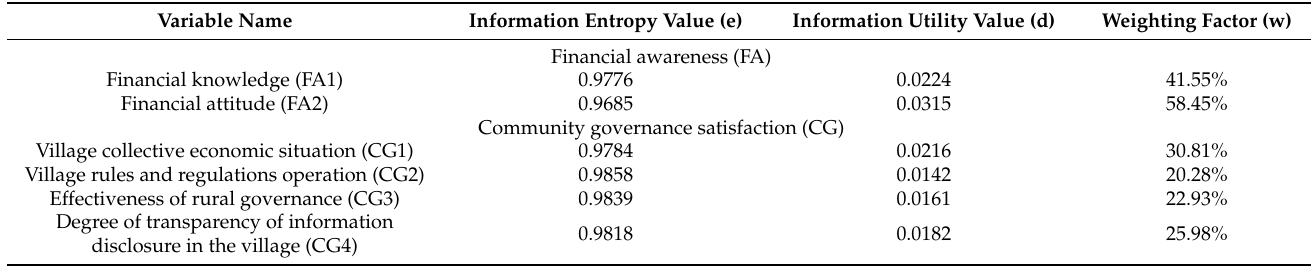
Table 6. Calculation of the weights of each